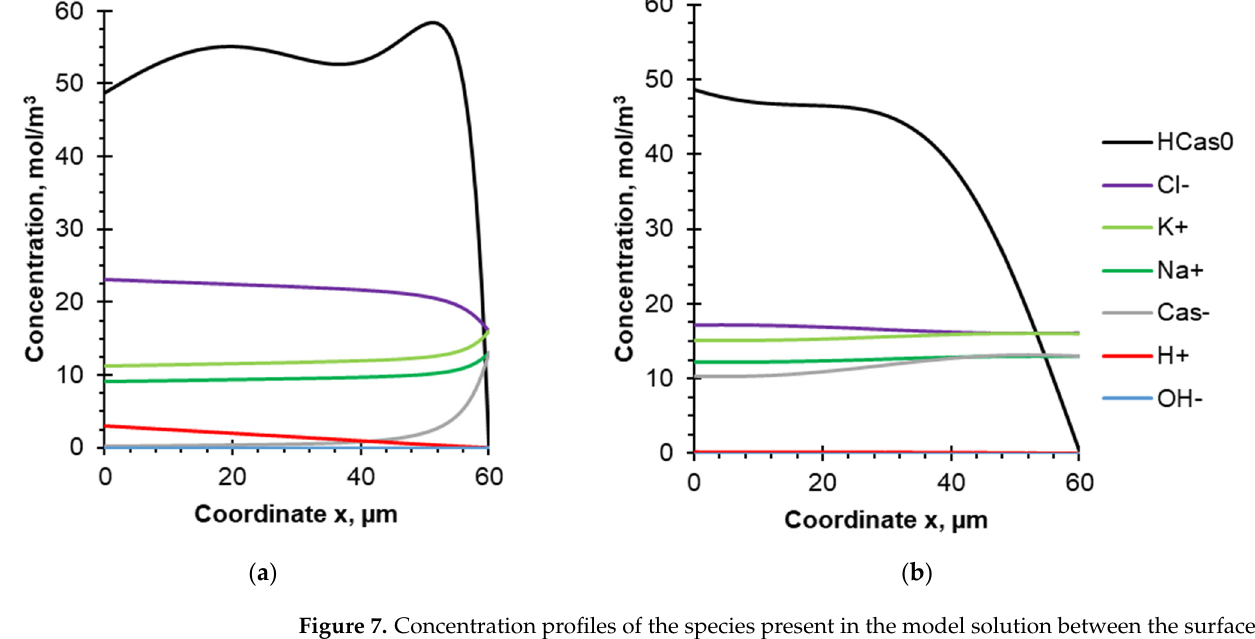
Figure 7. Concentration profiles of the species present in the model solution between the surface of the BPM cation-exchange layer (x = 0) and the outer boundary of the DBL (x = 60 µm). Calculations are made for the PEF mode 10 s-10 s at: ( a ) the end of the pulse lapse (3568.8 s after the current was turned on); ( b ) the end of the pause lapse (3579.1 s after the current was turned on). The steady-state condition and flow rate corresponding to Re = 187 and δ = 60 µm are considered.